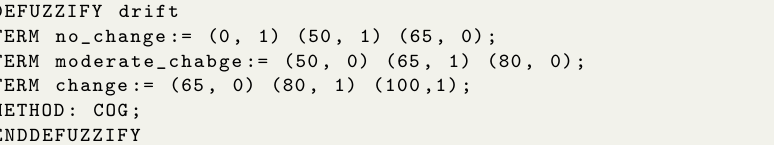
Code 3: Configuration example of the drift sets using